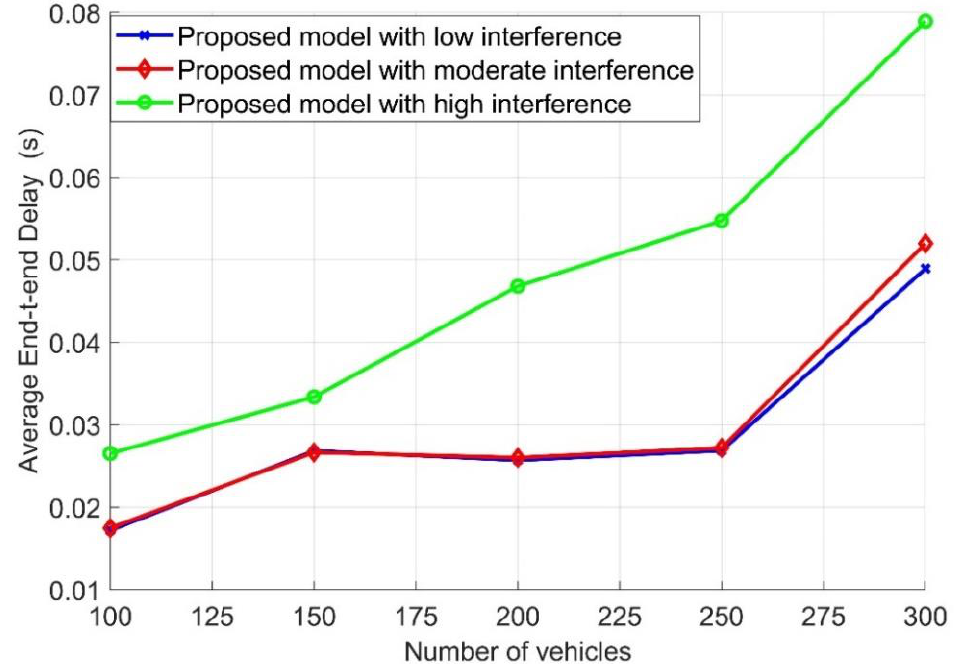
Figure 8. Average end-to-end delay (E2E) versus the number of vehicles.